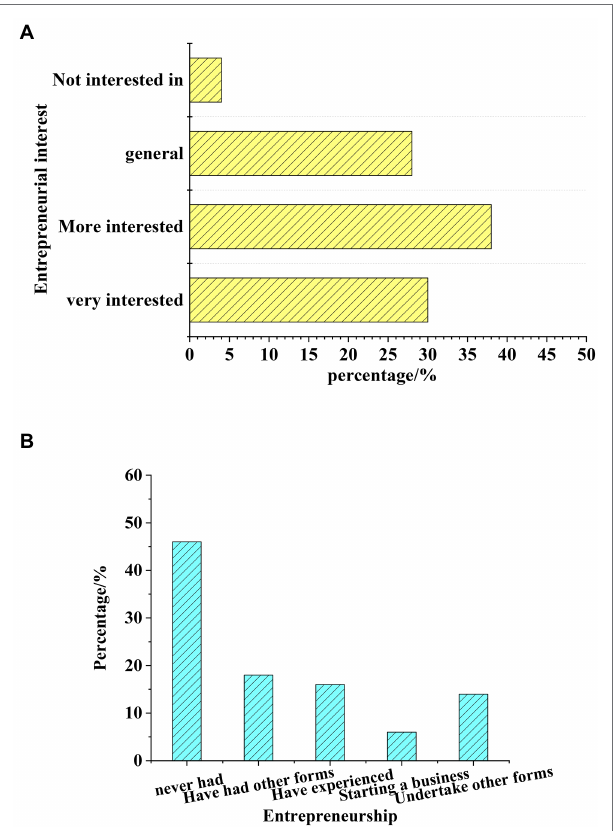
FIGURE 6 | Statistics of the students’ entrepreneurship. (A) Statistics of their entrepreneurship interest. (B) Statistics of their